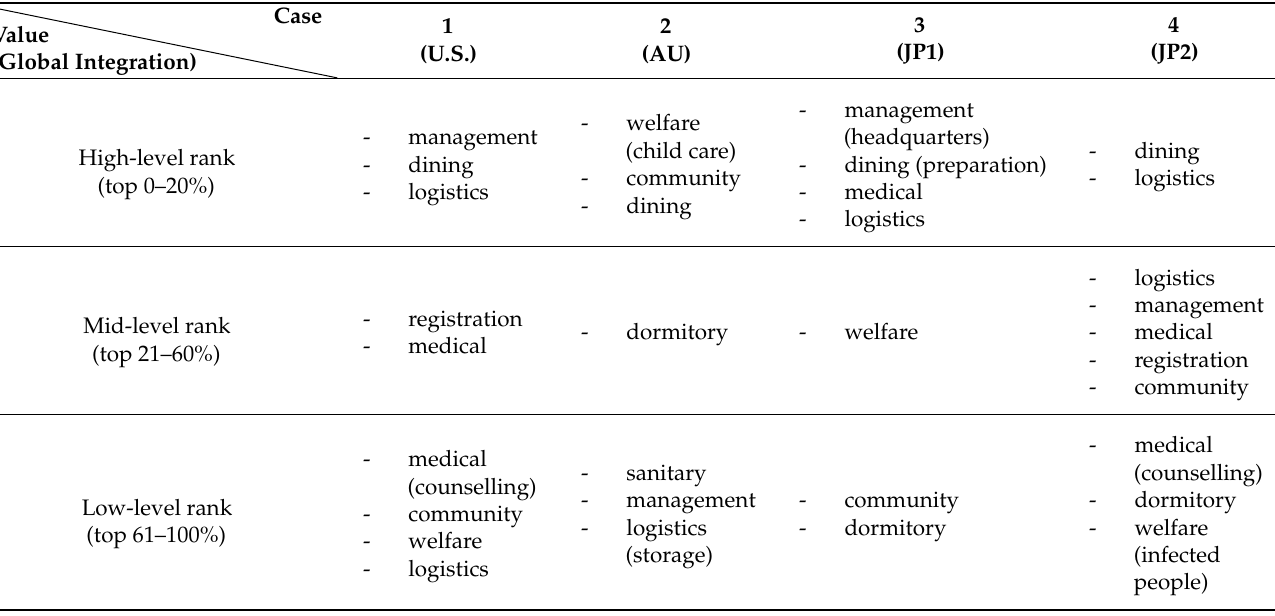
Table 3. Global integration of shelter rooms by